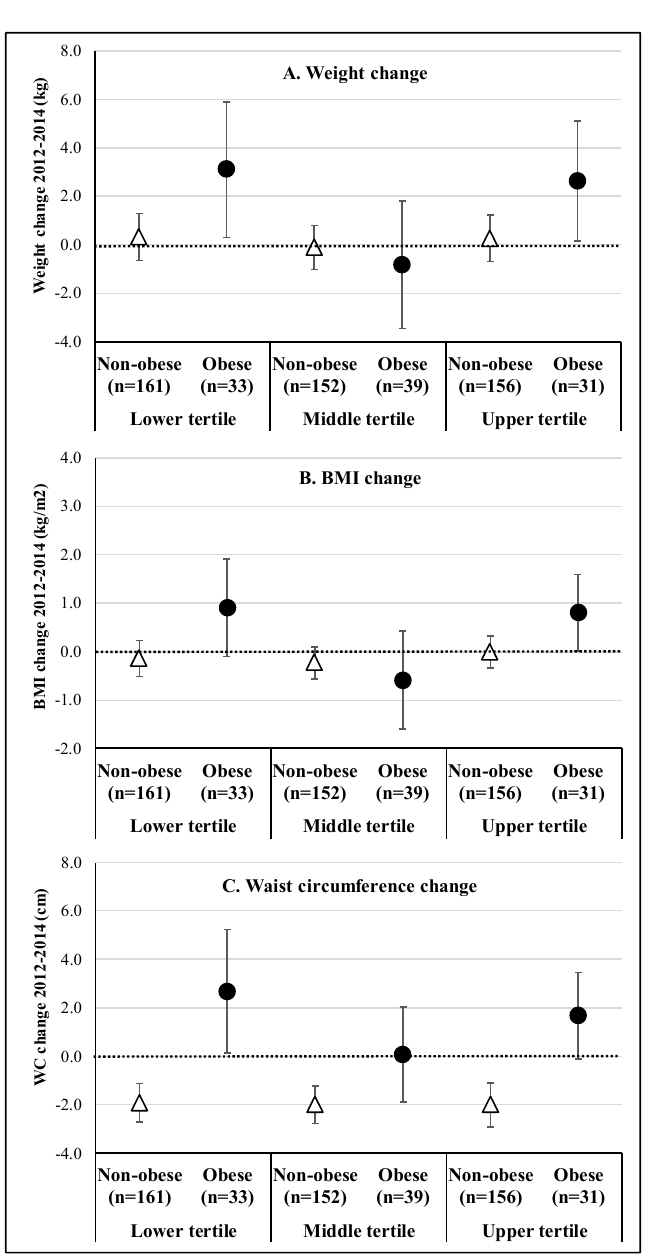
Figure 2. Adjusted a association between vitamin D intake (2012) in tertiles and change variables (weight ( A ), BMI ( B ), and WC ( C )) between 2012 and 2014, stratified by the presence of obesity (BMI ≥ 30.0 kg/m 2 ) at baseline. a = Adjusted for sociodemographic characteristics (sex, age, educational level, skin color, relationship status, family income per capita), vitamin supplementation, anthropometric measurement (height, weight, WC) and BMI at the beginning of the period (2012). Vertical lines represent the 95% confidence intervals.